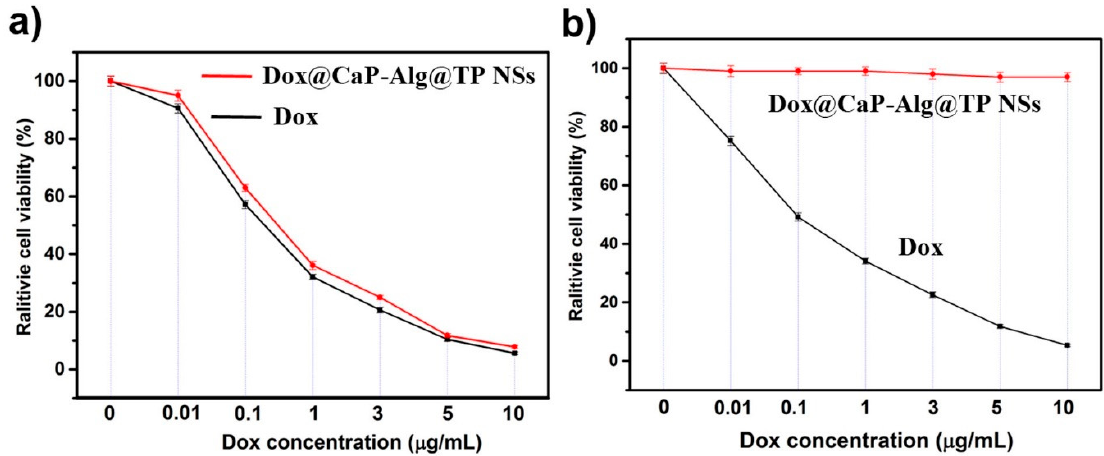
Figure 8. Cell viability results of cells cultured with DCAT NSs and free Dox under various concentrations: ( a ) MG63 cells and ( b ) MC3T3 cells. concentrations: ( a ) MG63 cells and ( b ) MC3T3